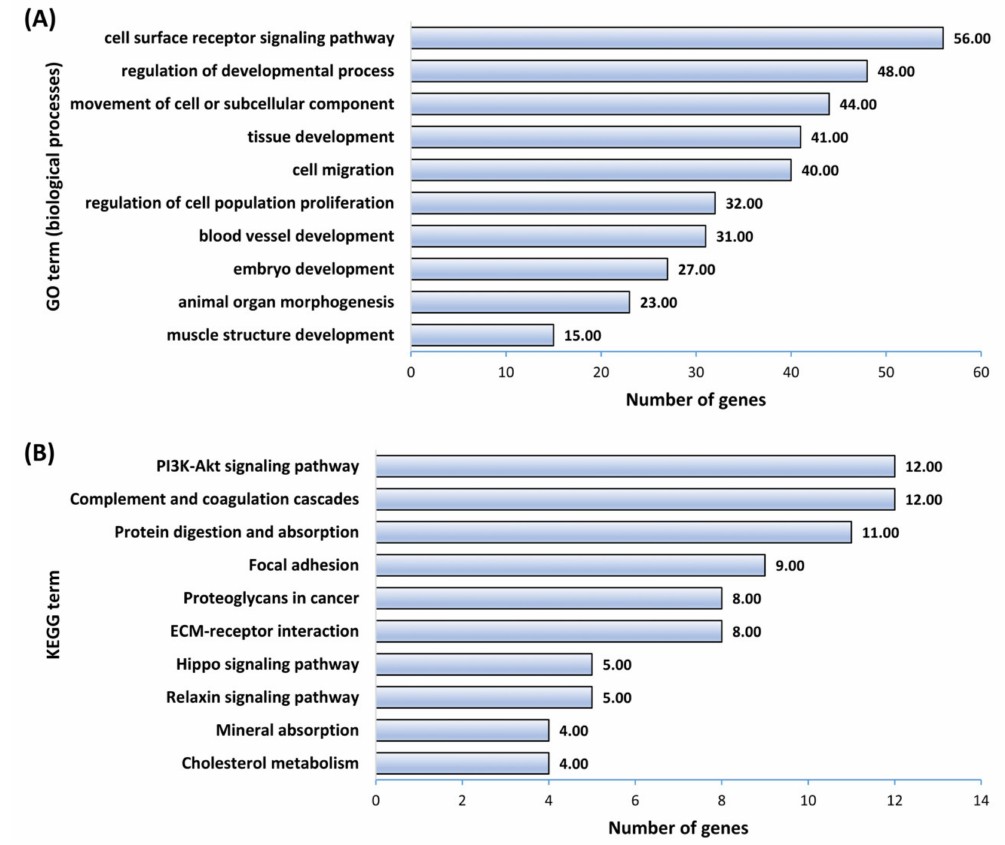
Figure 9. GO and KEGG pathway enrichment analysis for let-7 target genes downregulated in both AKD and BKD TE. Figure shows ( A ) 10 significantly enriched BPs and ( B ) 10 significantly enriched KEGG pathways important for placental or fetal development. A complete list of BPs and KEGG pathways significantly enriched by downregulated let-7 target genes is provided in Table